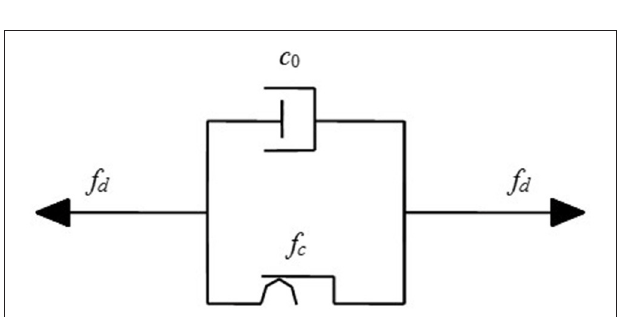
FIGURE 2 | Bingham model (Guo et al.,